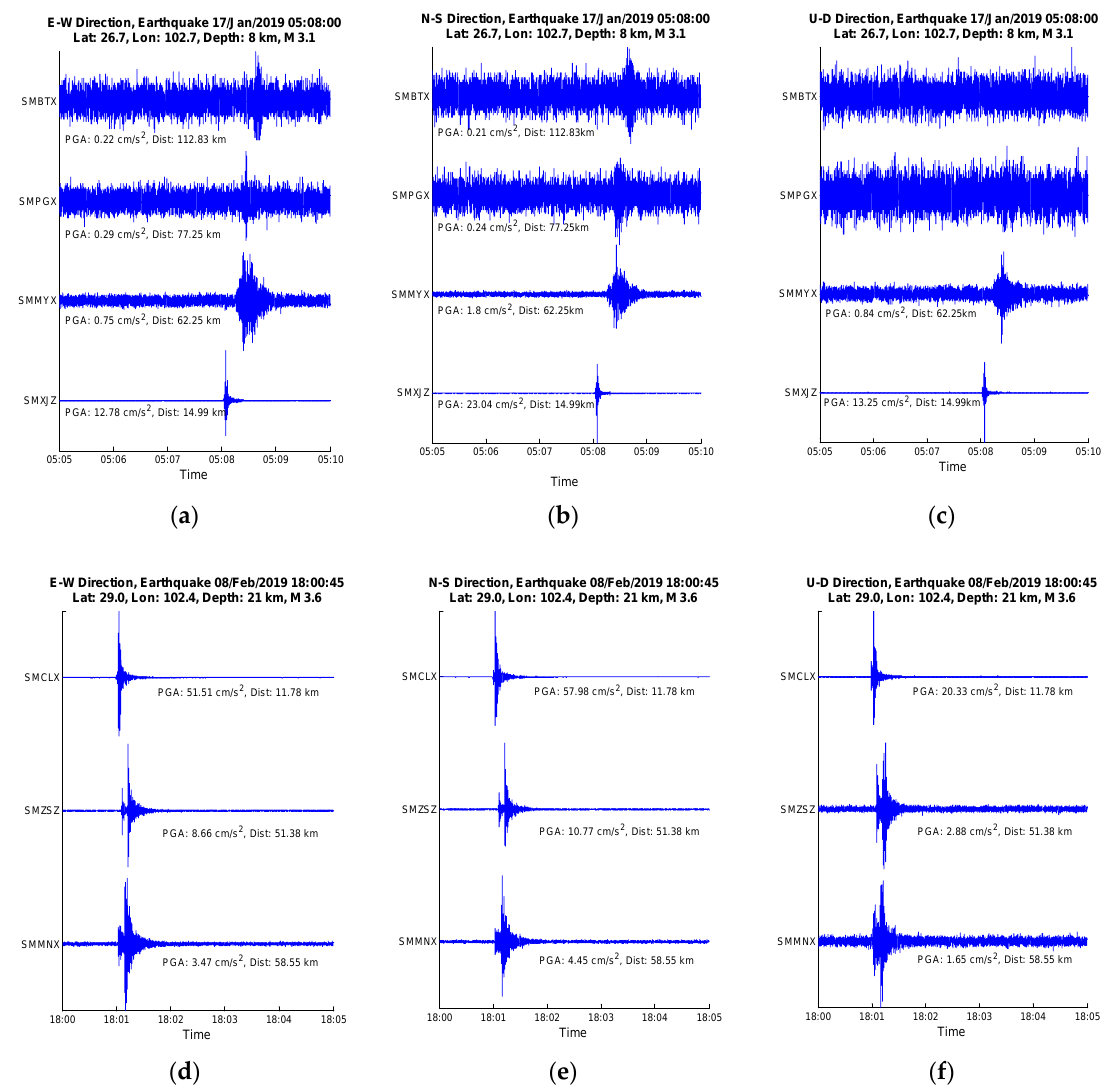
Figure 5. Ground motion records by the MNSMS network: ( a ) ( b ) and ( c ) E-W, N-S, and U-D directions of ground motion records for the earthquake M 3.1 occurred at Lat. 26.7° and Lon. 102.7° on January 17, 2019 5:08 am respectively; ( d ) ( e ) and ( f ) E-W, N-S, and U-D directions of ground motion records for the earthquake M 3.6 occurred at Lat. 29.0° and Lon. 102.4° on Feb. 8, 2019 6:00 pm respectively.